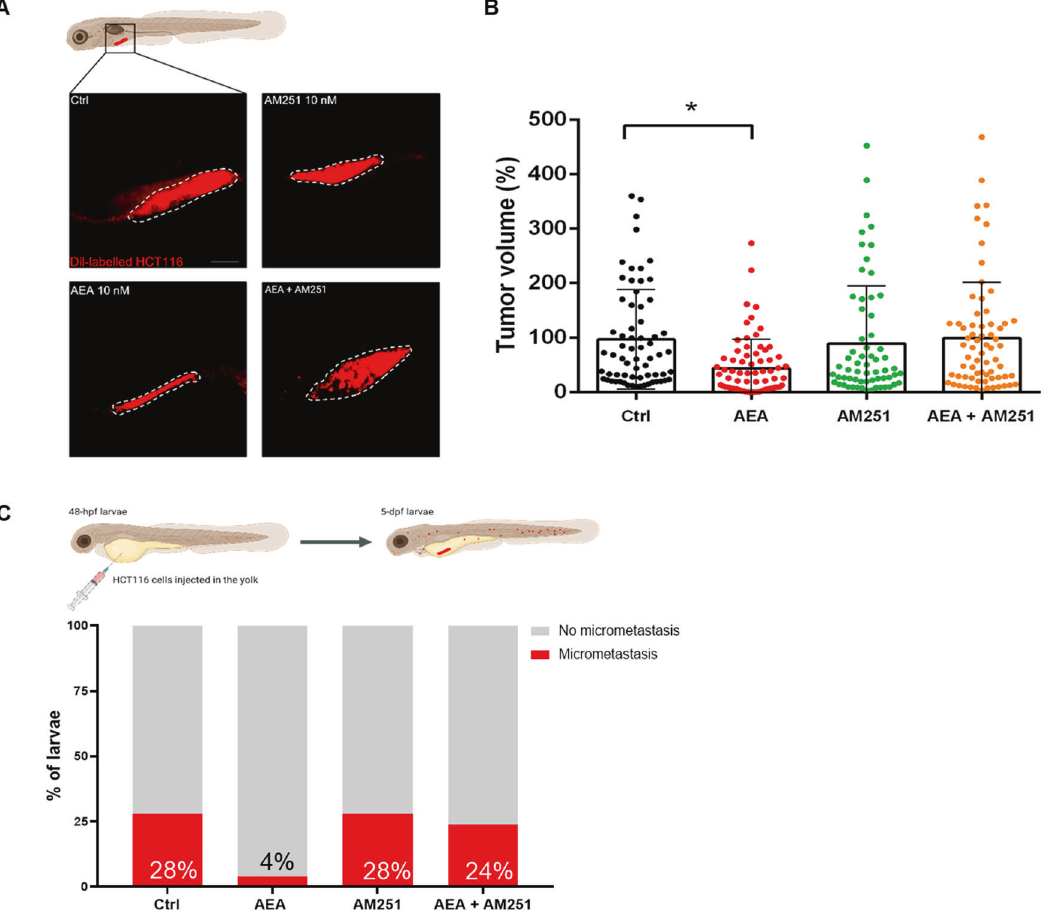
Fig. 1 AEA exposure controls tumor size and metastasis onset in xenografts. A Representative confocal z-stack images of 5 dpf (3 dpi) larvae with tumor cells marked by the red fl uorescence (Dil Vibrant red staining). Scale bar 100 µm. B Quanti fi cation of total Dil Vibrant Red fl uorescence. The mean value of the tumor size in Ctrl was settled as 100%. The error bar indicates SEM. C Percentage of larvae presenting micrometastasis in the four experimental conditions. (Ctrl n = 66; AEA n = 73; AM251 n = 63; AEA + AM251 n = 69 from fi ve independent experiments). Statistical analysis was performed using one-way ANOVA. * p < 0.01. Image created with